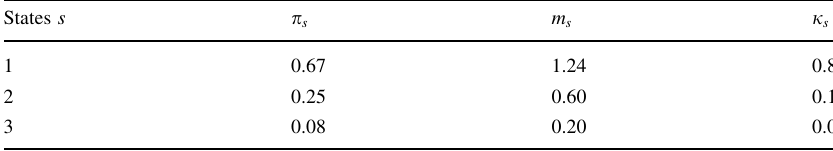
Table 2 Summary of pricing